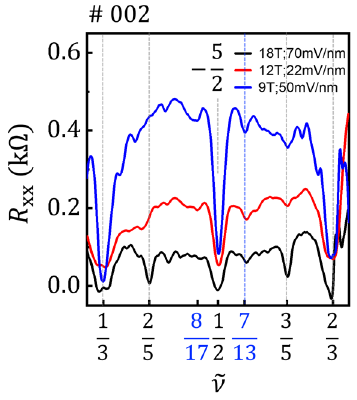
FIG. 11. Revised Fig. 11(b) with data plotted using ˜ ν ¼ ν − ½ ν (cid:2) , where ½ ν (cid:2) ¼ − 3 for ν ¼ − 5 = 2